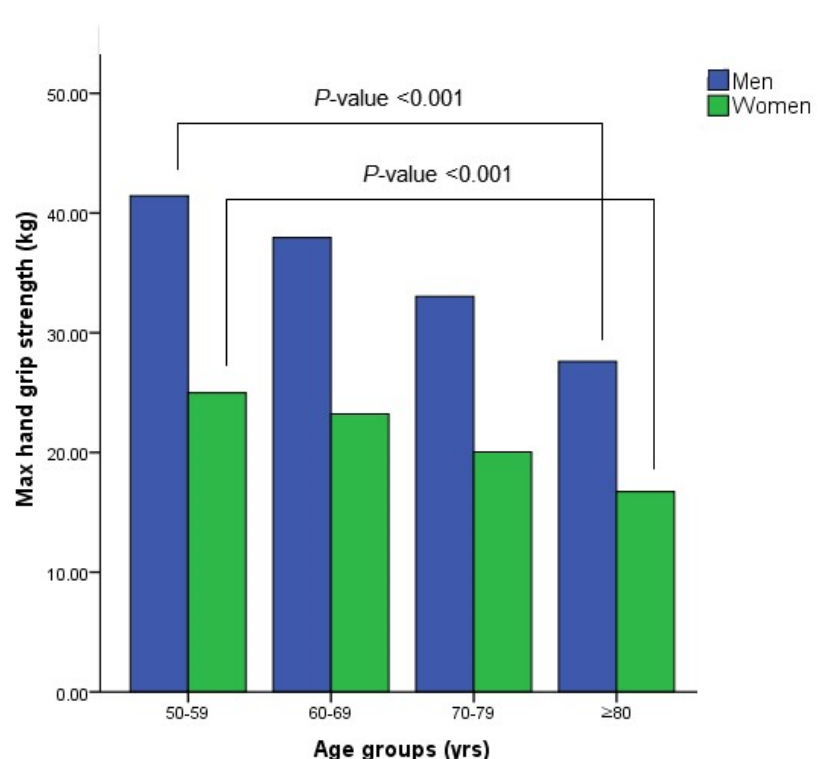
Figure 1. Distribution of hand grip strength according to age groups and sex. Table 2. Different characteristics that were related with functional disability according to age